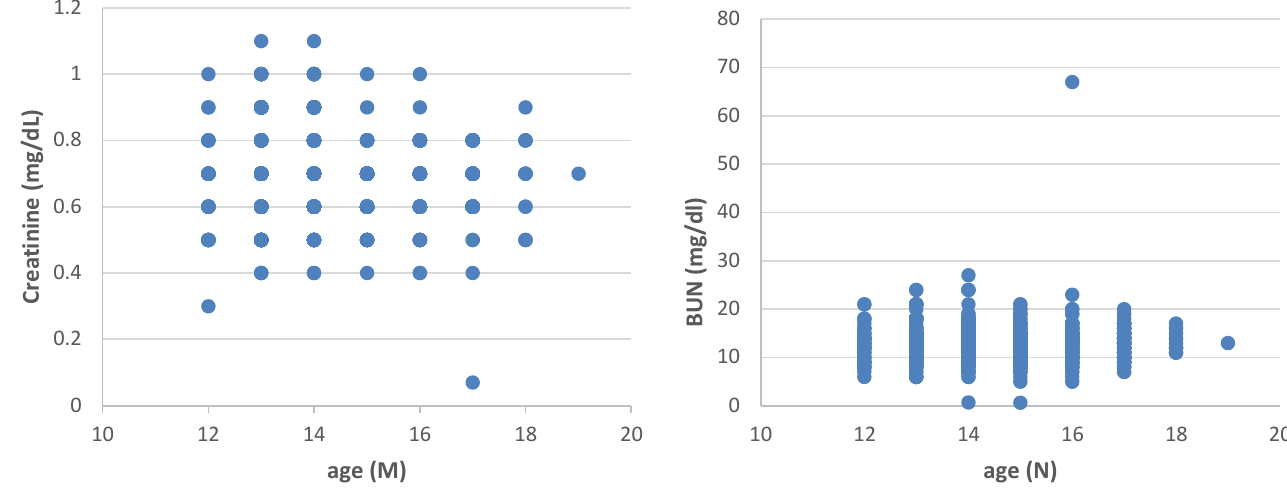
Continue Figure 1. Scatterplot distribution for serum total cholesterol (mg/dL), triglyceride (mg/dL), low- density lipoprotein (mg/dL), high-density lipoprotein (mg/dL), fasting blood sugar (mg/dL), AST (U/L), ALT (U/L), ALP (U/L), Hs-CRP (mg/L), calcium (mg/dL), phosphate (mg/dL), vitamin D (ng/dL), creatinine (mg/dL), blood urine nitrogen (mg/dL) (A-N). Blue horizontal lines depict adolescent girls-specific lower and upper reference limits.